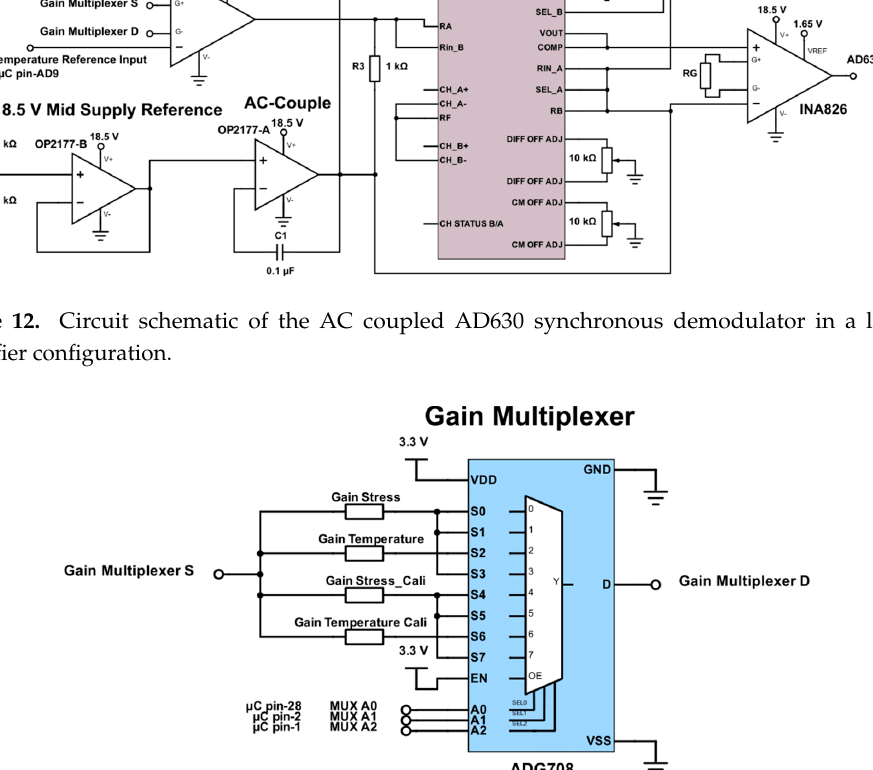
Figure 12. Circuit schematic of the AC coupled AD630 synchronous demodulator in a lock-in amplifier configuration.